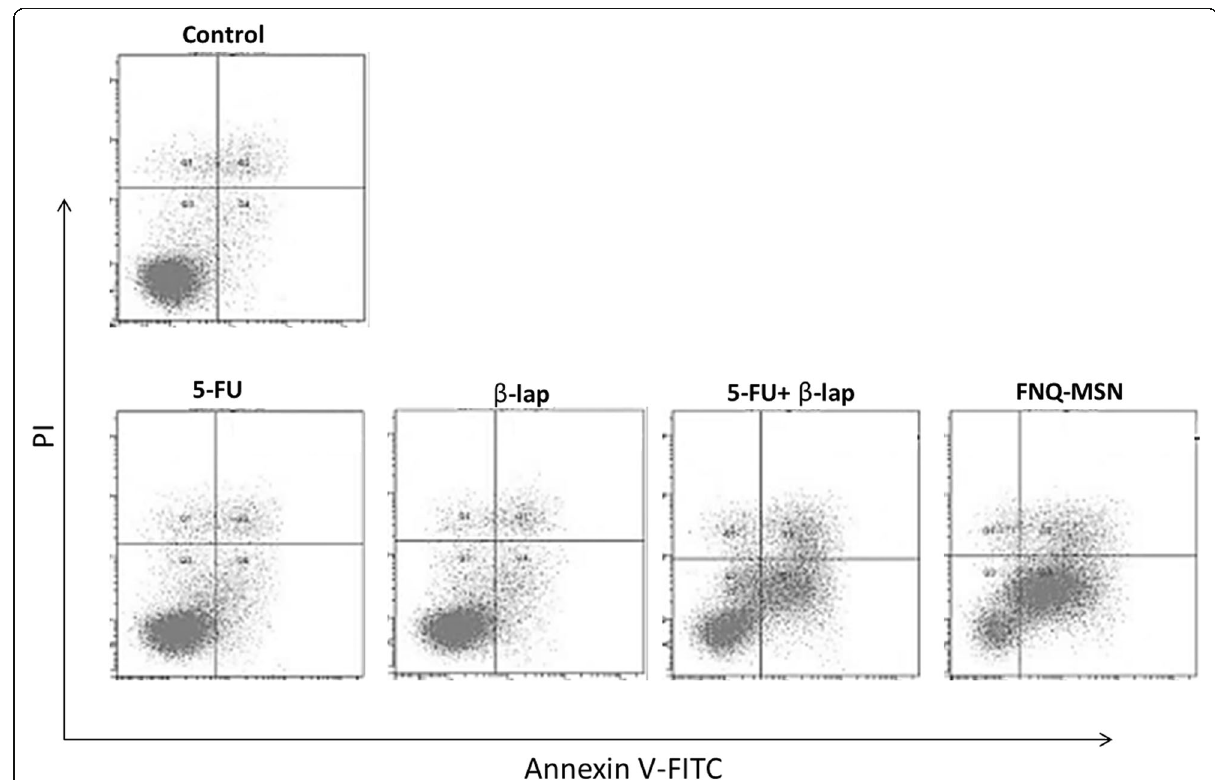
Fig. 5 Flow cytometer analysis of Cal33 cells using double staining of annexin V and PI after treatment with individual and combination of 5-FU and ß-lap. 10,000 events were recorded in the flow